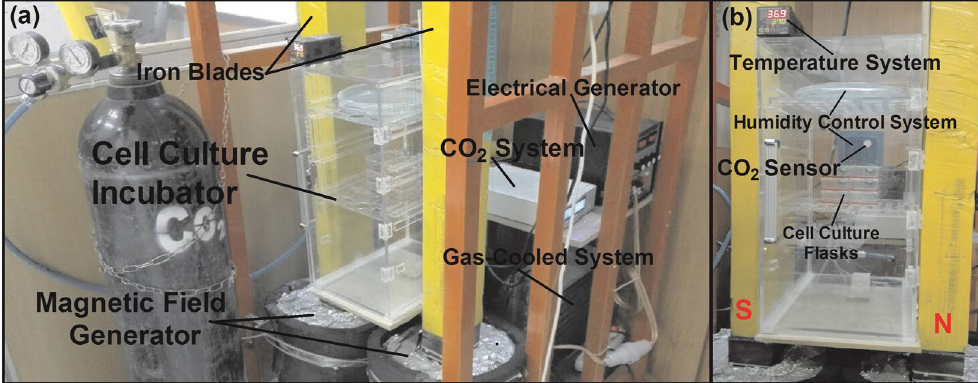
Figure 8. Illustration of magnetic field exposure system. ( a ) The whole body of exposure system. ( b ) The movable plexiglass incubator (exposure unit) within iron blades for providing standard conditions of cell